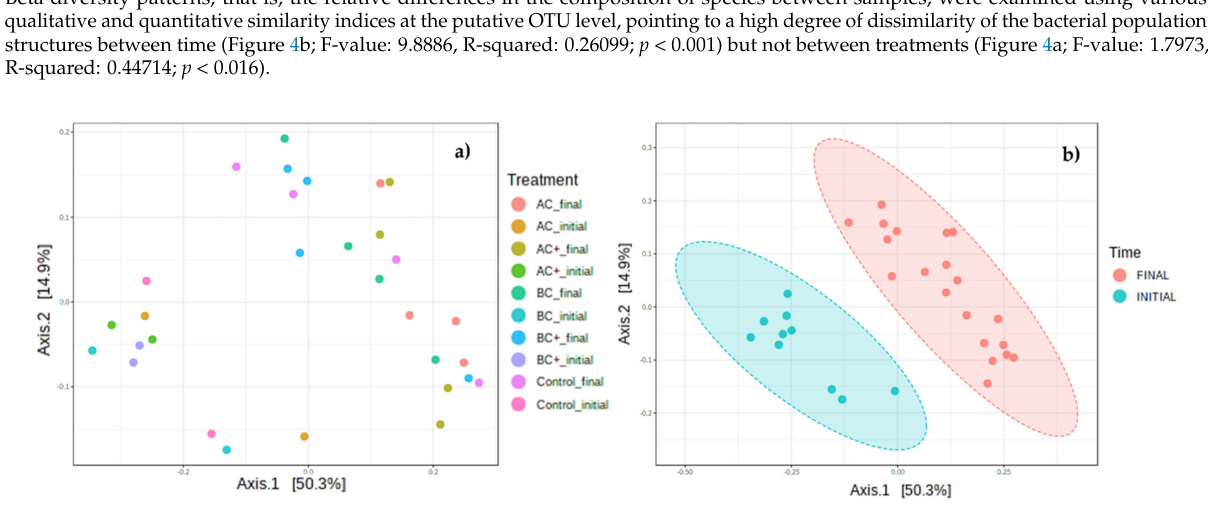
Figure 4. Effect of treatment ( a ) and time ( b ) on bacterial beta diversity in control soil and amended soils at low (AC and BC soils) and high doses (AC+ and BC+ soils). Ordination method PCoA; distance method: Bray–Curtis index; statistical method: PERMANOVA. Ellipses were drawn only when 95% of the data fell inside the